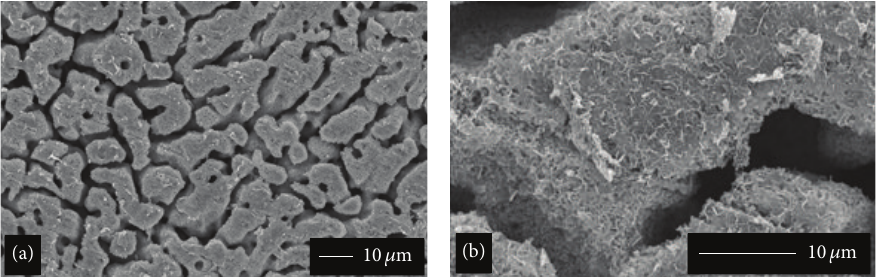
Figure 6: Al-35 at.% Zn alloy quenched in liquid nitrogen and electrochemically corroded in HNO 3 . (a) Passivated aluminum dendrites forming interconnected three-dimensional structure. (b) Secondary porosity.